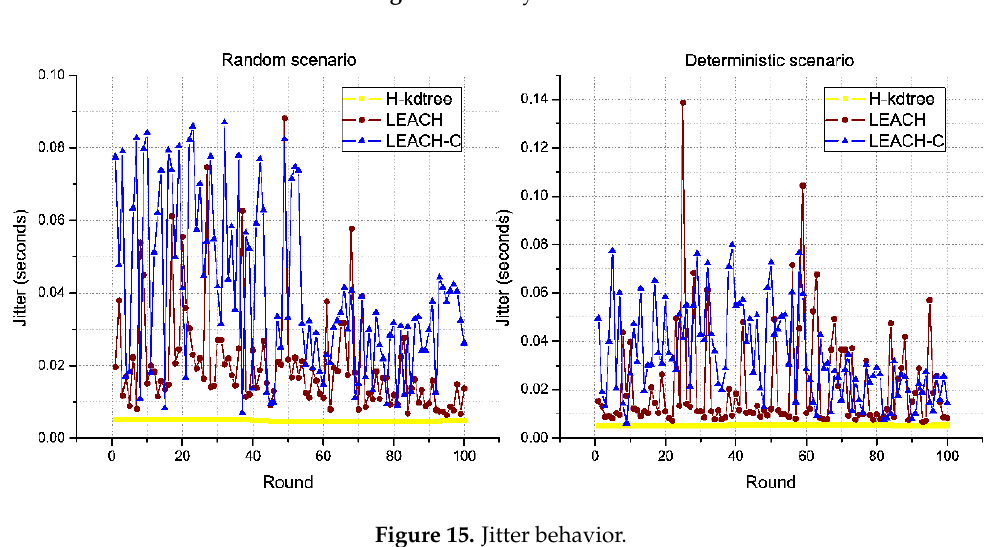
Figure 14. Delay behavior.